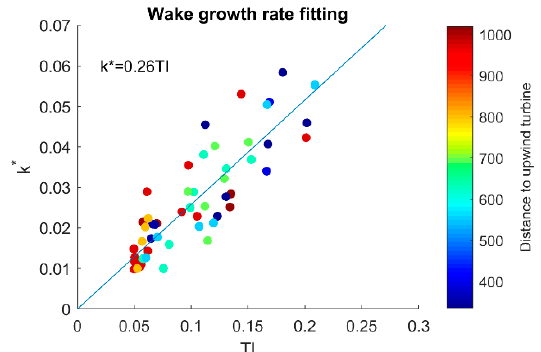
Figure 3. Relationship between the wake growth rate and longitudinal turbulence intensity. Data were selected from 52 cases at 11 di ff erent distances. The line is the linear fit of the data, R 2 = 0.73 .